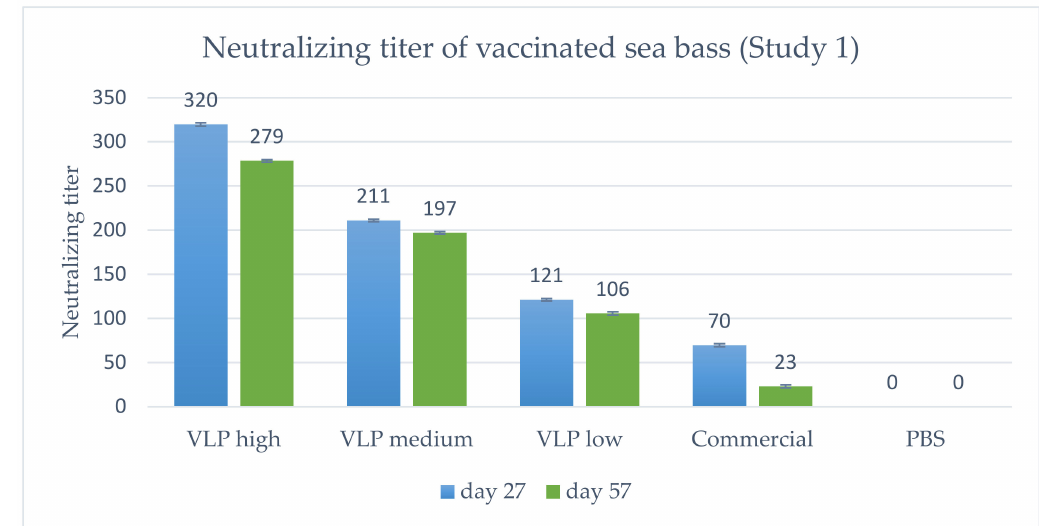
Figure 6. Geometric mean neutralizing titer in vaccinated fish on Day 27 ( n = 5) or 57 ( n = 10) post-vaccination, Study 1. VLP high = 20 µ g/fish, medium = 5 µ g/fish or low = 1.25 µ g/fish. Bars indicate geometric standard deviation. The lowest serum dilution analyzed was 1:20, which is why a negative sample was <1:20. When calculating the geometric mean titer, these were set to a value of 10, except in the PBS group where all were <1:20, and set as